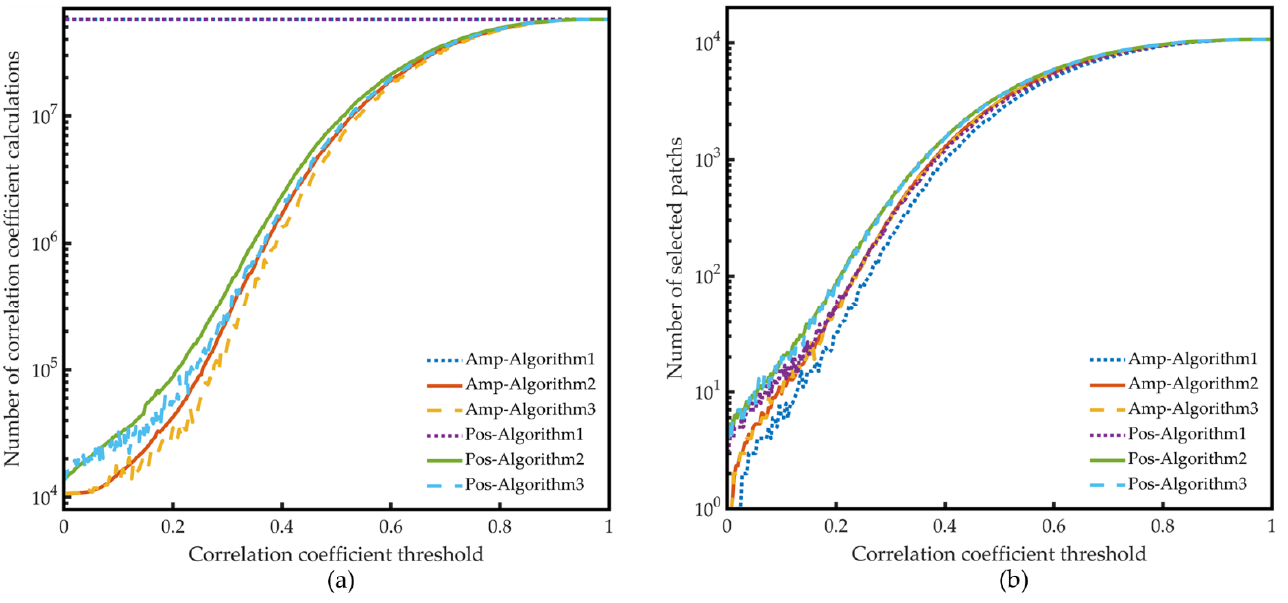
Figure 10. Comparison of the three compression algorithms based on data selection: ( a ) the number of correlation coefficient calculations and ( b ) the number of selected patches of the three algorithms under different correlation coefficient thresholds. (Amp means the correlation coefficient thresholds are set for CorrAmp , and Pos means the correlation coefficient thresholds are set for CorrPos .). As can be observed in Figure 10, although in spatial compression, Algorithm 3 still performed better than Algorithm 2, the improvement is limited. The reason is that alt- hough patches with adjacent numbers might be close to each other in the spatial dimen- sion and even have certain overlapping regions, these effects on the spatial correlation between patches are not decisive, and the scope of these effects is limited. Therefore, the